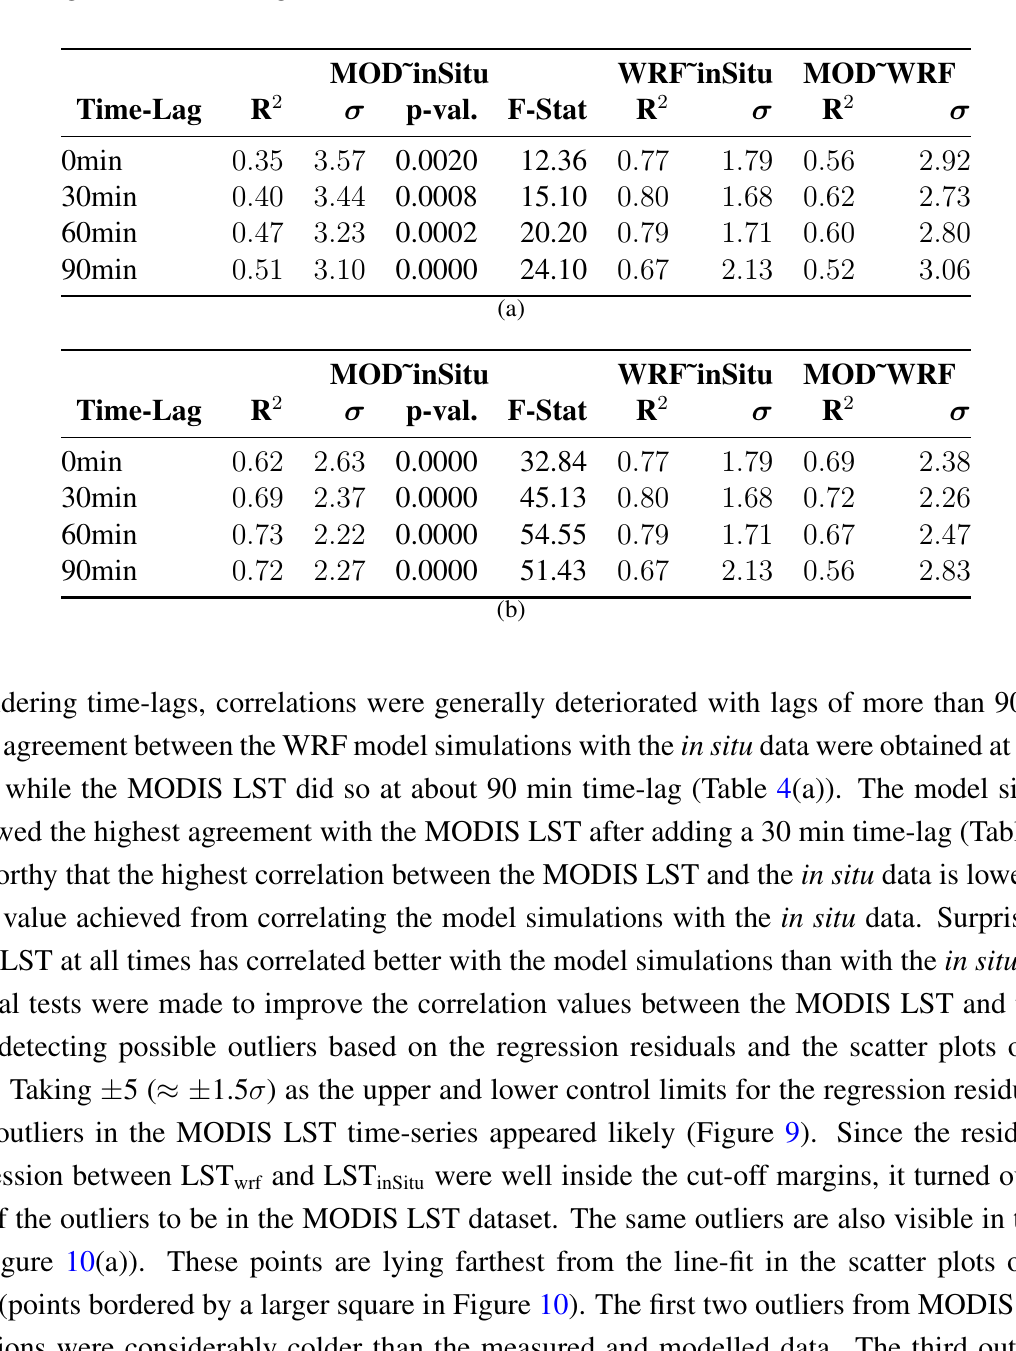
Table 4. Regression statistics from spatially averaged data, with and without outliers. P- values from the correlations between MODIS LST and iButton series are also provided, where the smaller the p-level, the more significant the relationship. ( a ) Regression statistics from original data; ( b ) Regression statistics after removal of